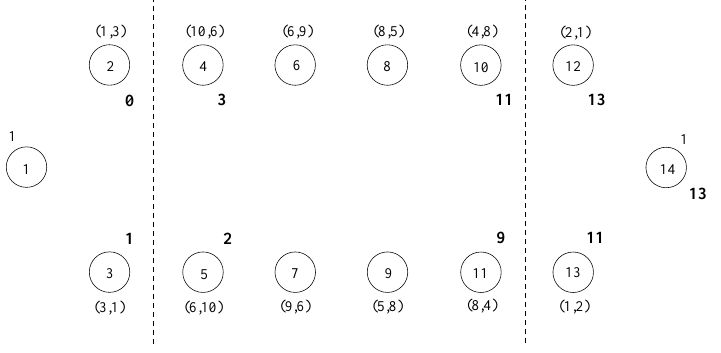
Figure 7: The layered graph L ∗ 0 obtained by performing the move TRANSFORM ( S 0 → S ∗ 0 ) = h h (5 , 2) , (4 , 3) , (3 , 4) , (2 , 5) i i . The labels calculated by the complexity reduction procedure are shown as bold numbers beside the relevant